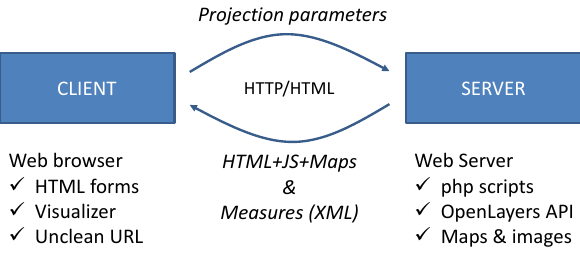
Figure 3. The overall architecture.